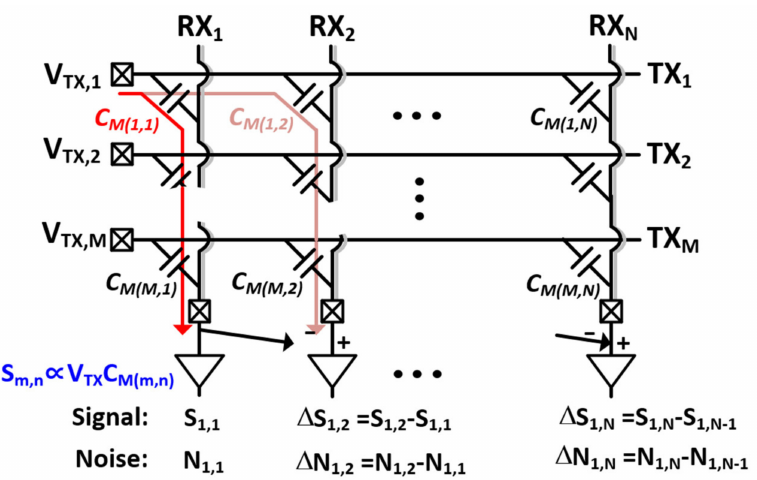
Figure 3. Illustration of the operation principle of a differential TSP sensing